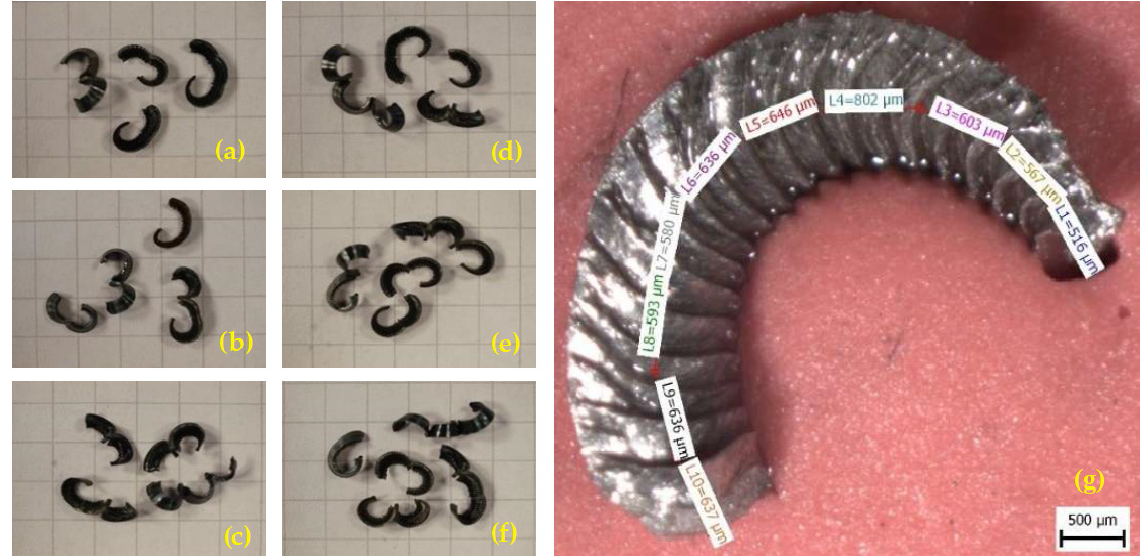
Figure 13. Exemplary macroscopic chip evaluation of CNMG 120408E-M GRADE T9315 indexable insert depending on the cutting time T [min]: ( a ) T = 1.5, ( b ) T = 3, ( c ) T = 4.5, ( d ) T = 6, ( e ) T = 7.5, ( f ) T = 9, ( g ) T = 10.5.